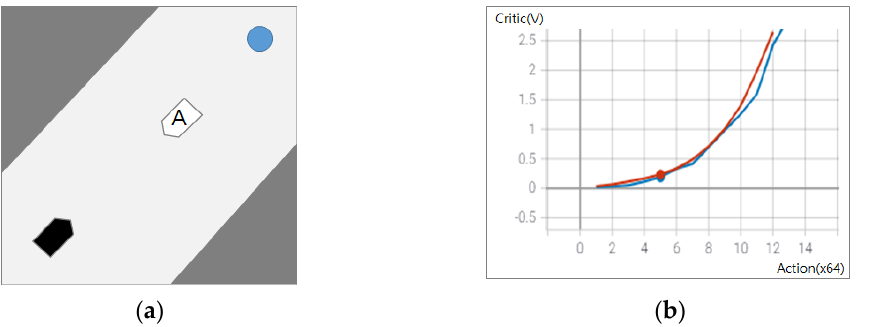
Figure 4. ( a ) Other ships approaching in front added to the autonomous ship (black) learned obstacle avoidance and basic path finding through the local curriculum. ( b ) Comparison of the values from the first learning scenario and those from 2000 scenario learnings to obtain the V w ( s t ) of the critic. To extract the critic value, ( ε ) is fixed, and the critic is activated before and after the learning. The additional training before (blue) and after (red) is compared. After additional training, the critic is higher with low actions.